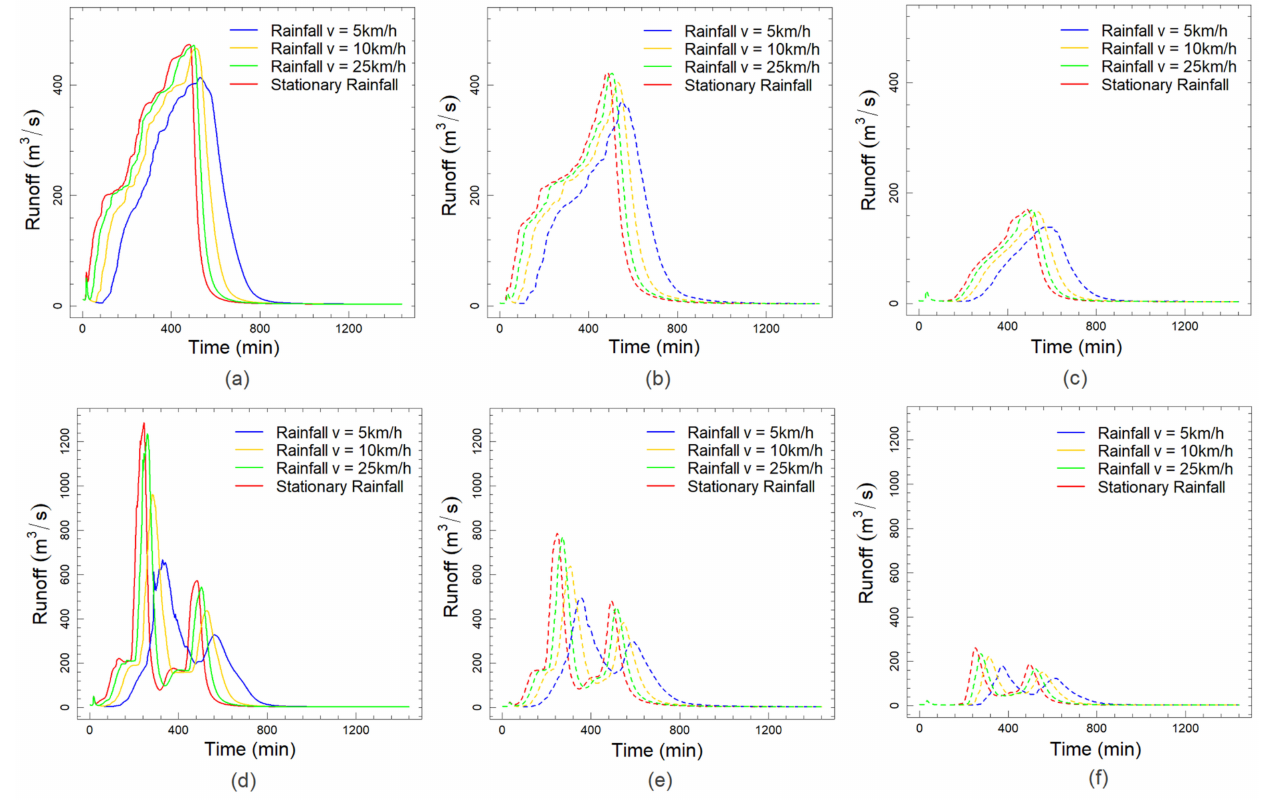
Figure 14. Hydrographs at measuring point A for rains σ 2 = 0 (Figure 3a) ( a – c ) and σ 2 = 99.2 (Figure 3f) ( d – f ) under an idealized setup ( a , d ), with consideration of heterogeneous roughness ( b , e ) and setup with consideration of both roughness and infiltration ( c , f ). Storm movement is from west to east with velocities v = 5, 10, and 25 km/h. Stationary rainfall scenarios are also